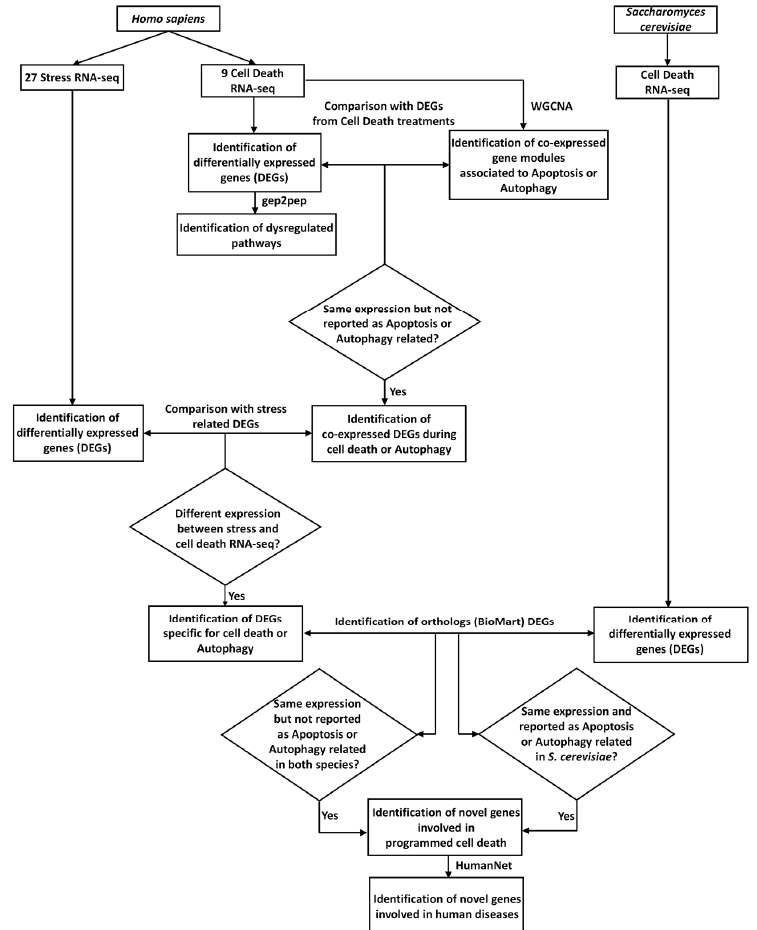
Figure 1. Scheme of the analytical procedure here proposed. Collection of RNA-seq experiments related to cell death (nine cell death RNA-seq) and stress (27 Stress RNA-seq), for Homo sapiens, and related to cell death, for Saccharomyces cerevisiae (cell death RNA-seq), respectively. Differentially-expressed genes (DEGs) obtained from cell-death-related RNA-seq (identification of differentially-expressed genes (DEGs)) were used as for the identification of dysregulated pathways, using gep2pep (identification of dysregulated pathways). Normalized mapped reads related to cell death in H. sapiens were used for the co-expression analysis, using Weighted Correlation Network Analysis (WGCNA) (identification of co-expressed gene modules associated with apoptosis or autophagy). DEGs with the same expression pattern in the nine cell death RNA-seq experiments were compared with modules of co-expressed genes enriched in gene ontologies (GO) or pathways related to apoptosis and/or autophagy. DEGs with the same expression pattern, and not reported as apoptosis- or autophagy-related, were considered (identification of co-expressed DEGs during cell death). Subsequently, these DEGs were compared with stress-related DEGs, to identify DEGs specific to cell death (identification of DEGs specific for cell death). Independently, DEGs related to cell death for S. cerevisiae were also identified . Through the orthology relationships between H. sapiens and S. cerevisiae (downloaded from BioMart), DEGs specific for human cell death were compared with those from S. cerevisiae cell death . This analysis led to the identification of genes involved in cell death with conserved functionalities in the two species (identification of novel genes involved in PCD). Lastly, using HumanNet [43] the genes predicted to be involved in cell death were investigated for their involvement in human diseases (identification of novel genes involved in human diseases).